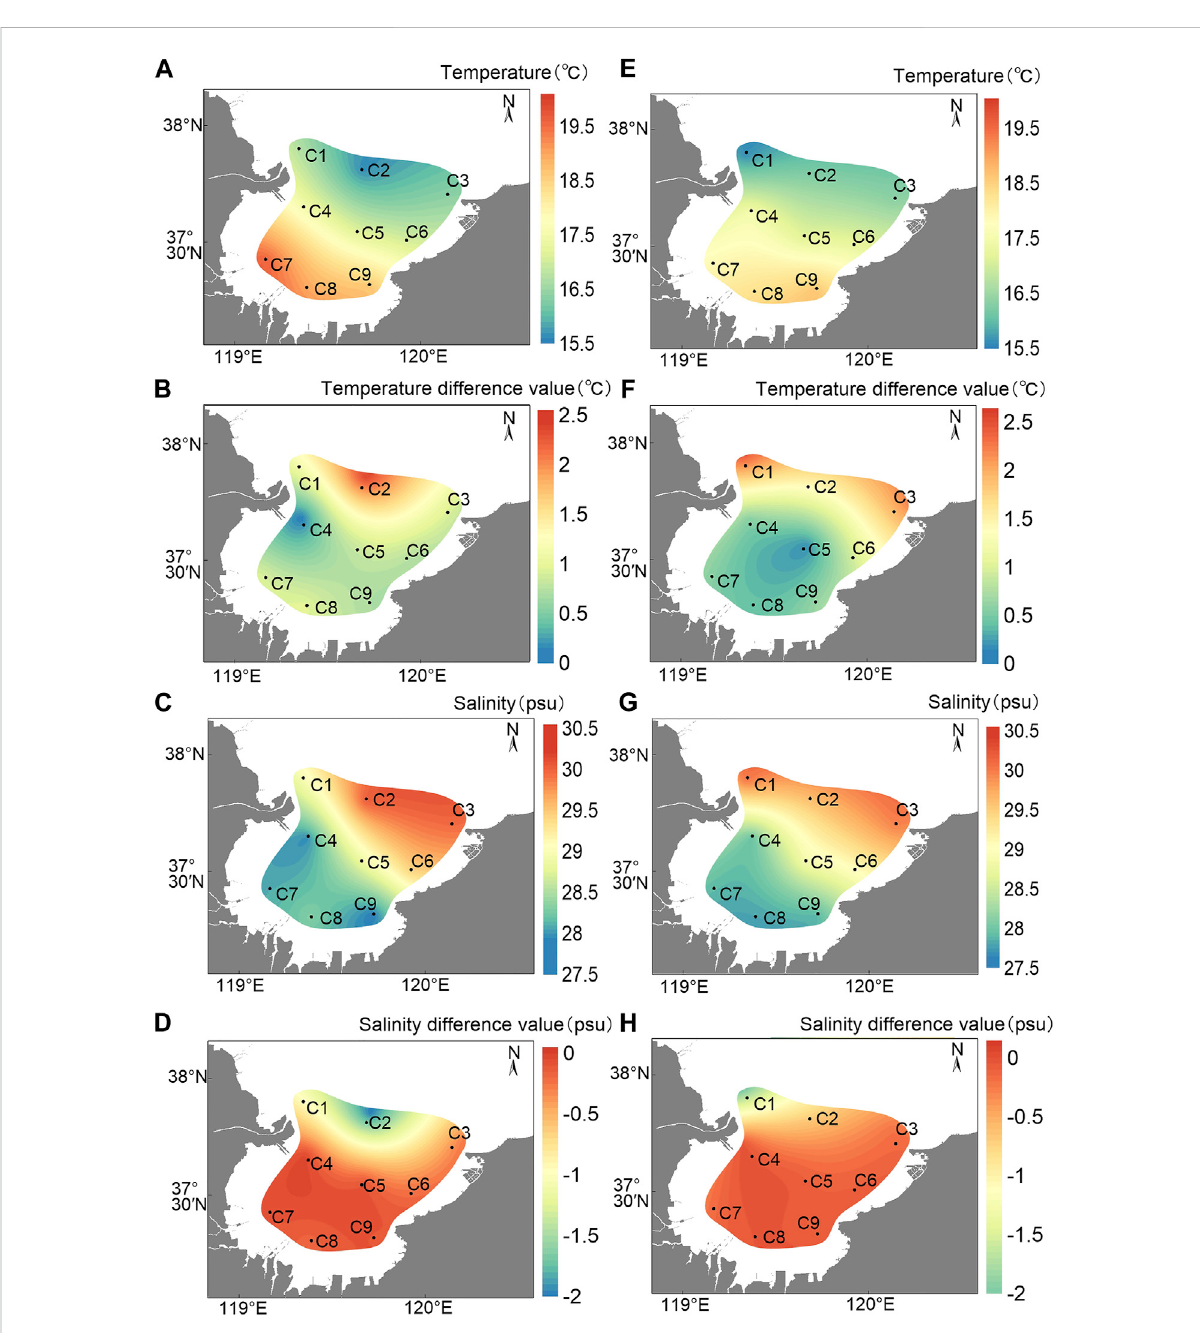
FIGURE 7 Contour of average temperature (A) and salinity (C) during the spring tide; surface minus bottom temperature (B) and salinity (D) difference during the spring tide; contour of average temperature (E) and salinity (G) during the moderate tide; surface minus bottom temperature (F) and salinity (H) difference during the moderate